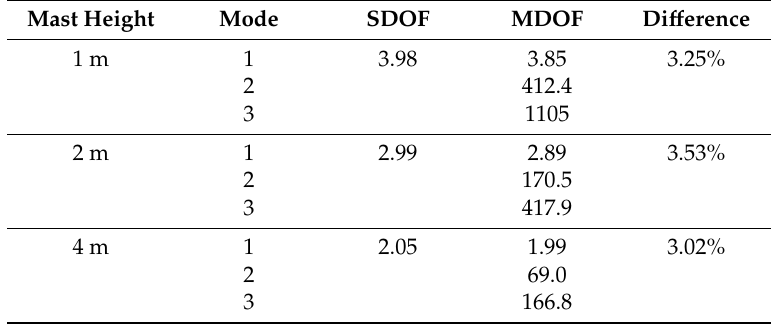
Table 7. First natural frequencies of the SDOF and MDOF models of the hybrid VAWT.